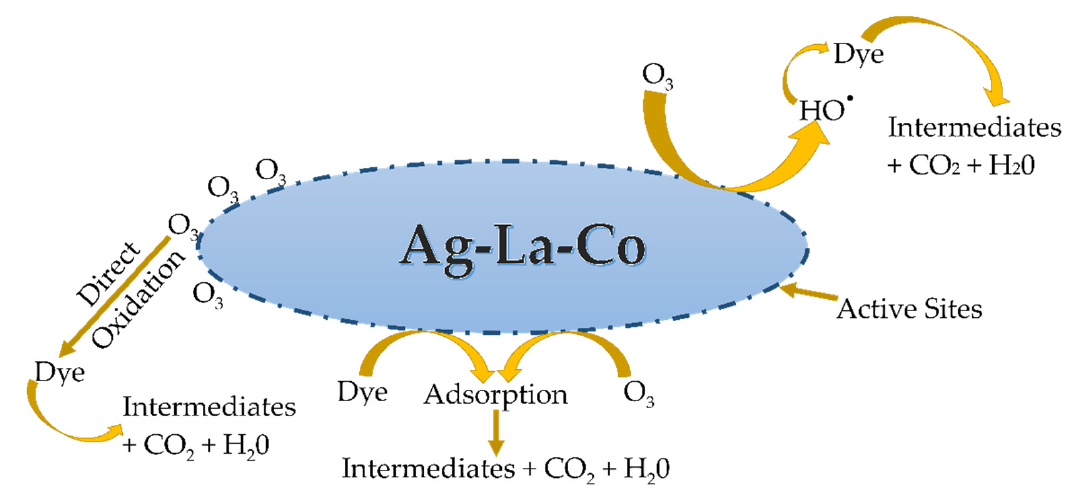
Figure 3. Proposed mechanisms of action of Ag-La-Co catalyst based on Chokshi, 2021 [96].